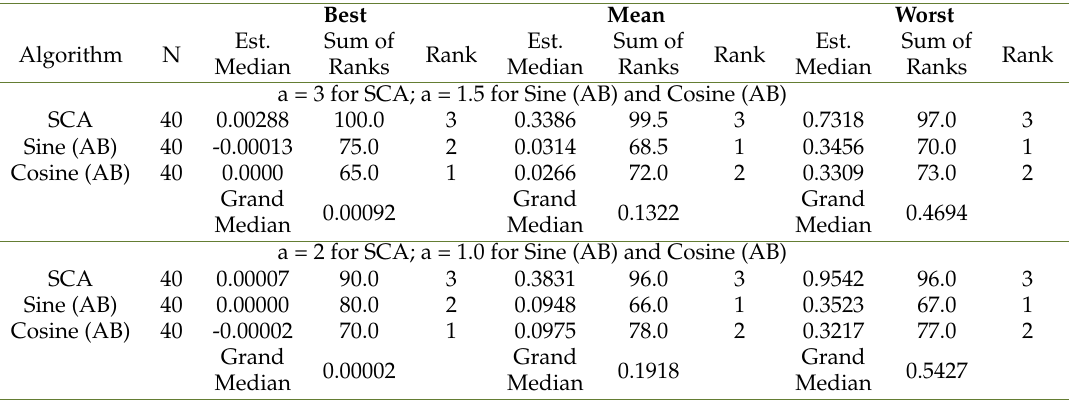
Table 13. Friedman